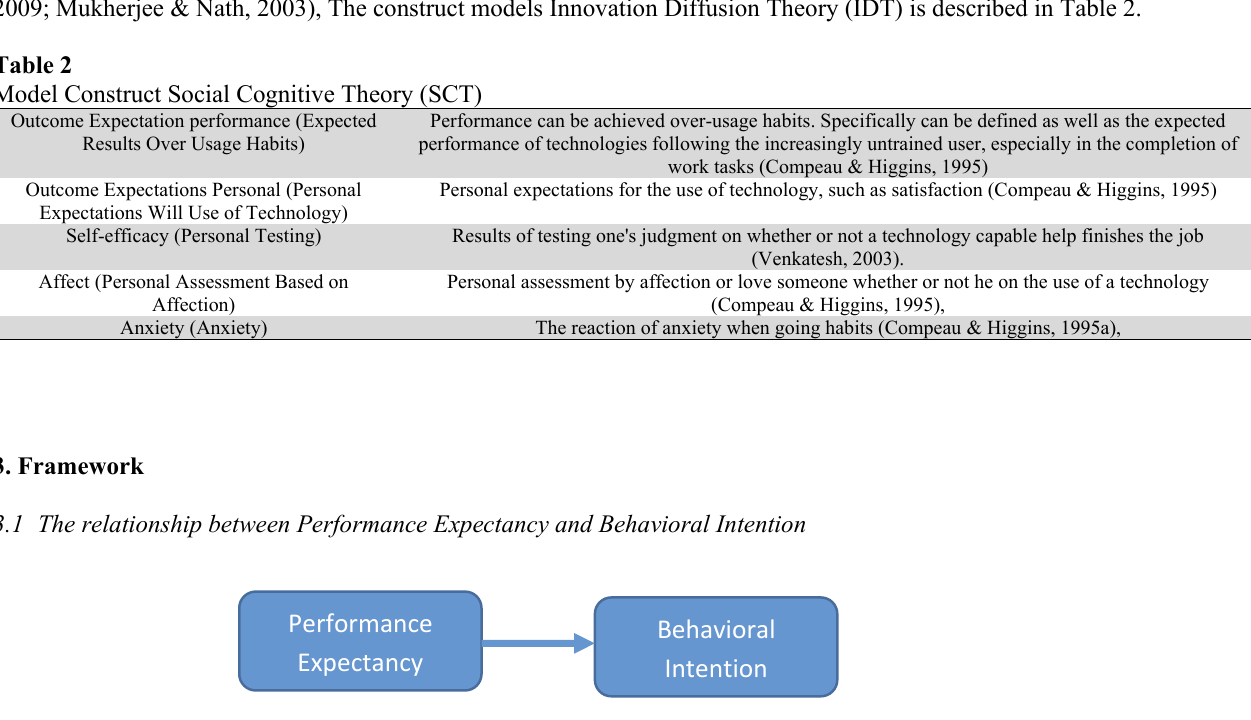
Fig. 1. Relations expectancy performance and behavioral intention Source (Tahrini, 2015)